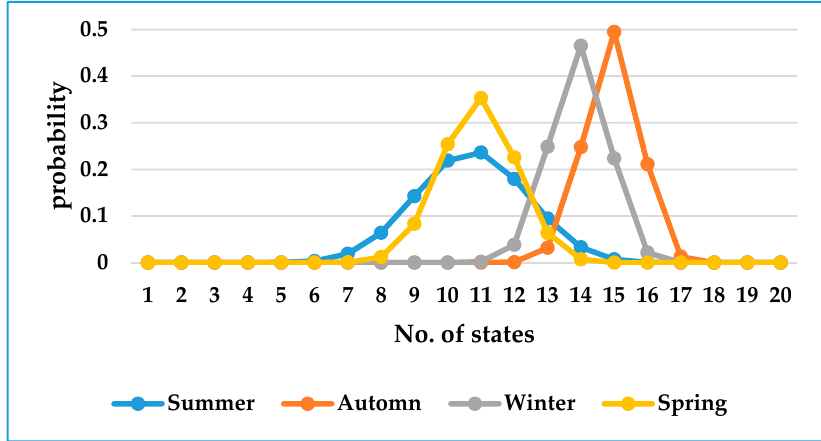
Figure 5. Probabilities of solar irradiance at each state during t th time hour.